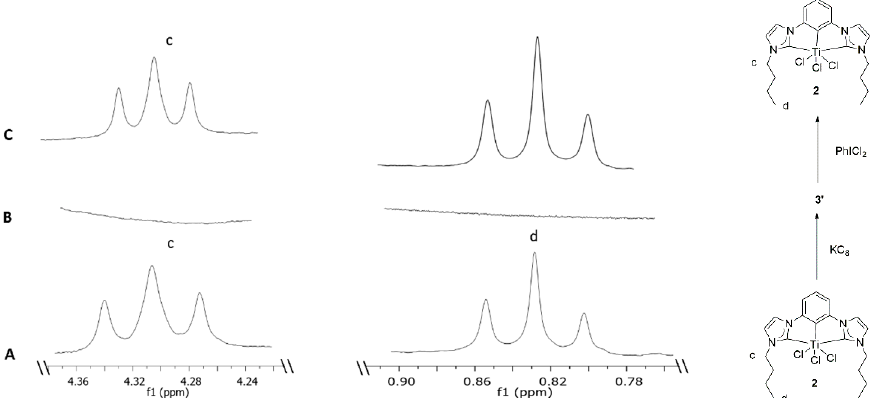
Figure 4. A stacked plot of characteristic peaks from the 1 H NMR spectra for reduction of 2 followed by reoxidation in no-D THF. ( A ) Characteristic triplet peaks (H c and H d ) of ((CCC-NHC)Ti(IV)Cl 3 ), 2 . ( B ) Relevant regions in the 1 H NMR spectrum of intermediate 3 '. ( C ) Characteristic triplet peaks of 2 (H c and H d ) in the 1 H NMR spectrum after the reoxidation reaction.